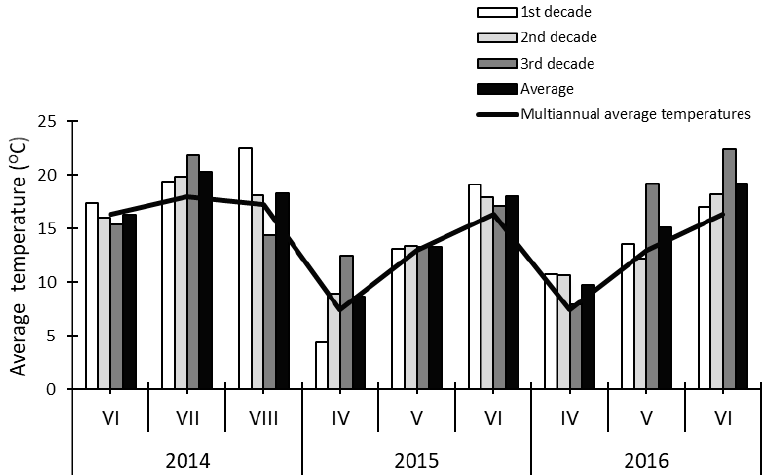
Figure 2. Mean air temperature during the vegetation of first crop alfalfa in the year of sowing (2014) and the production years (2015, 2016) in relation to the multiannual